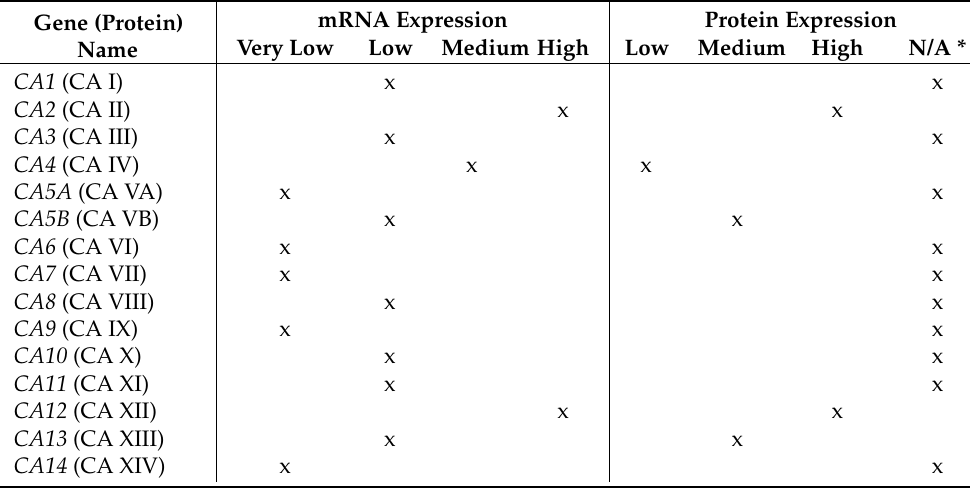
Table 2. Classification of human α -CA family members in the kidney. mRNA and protein